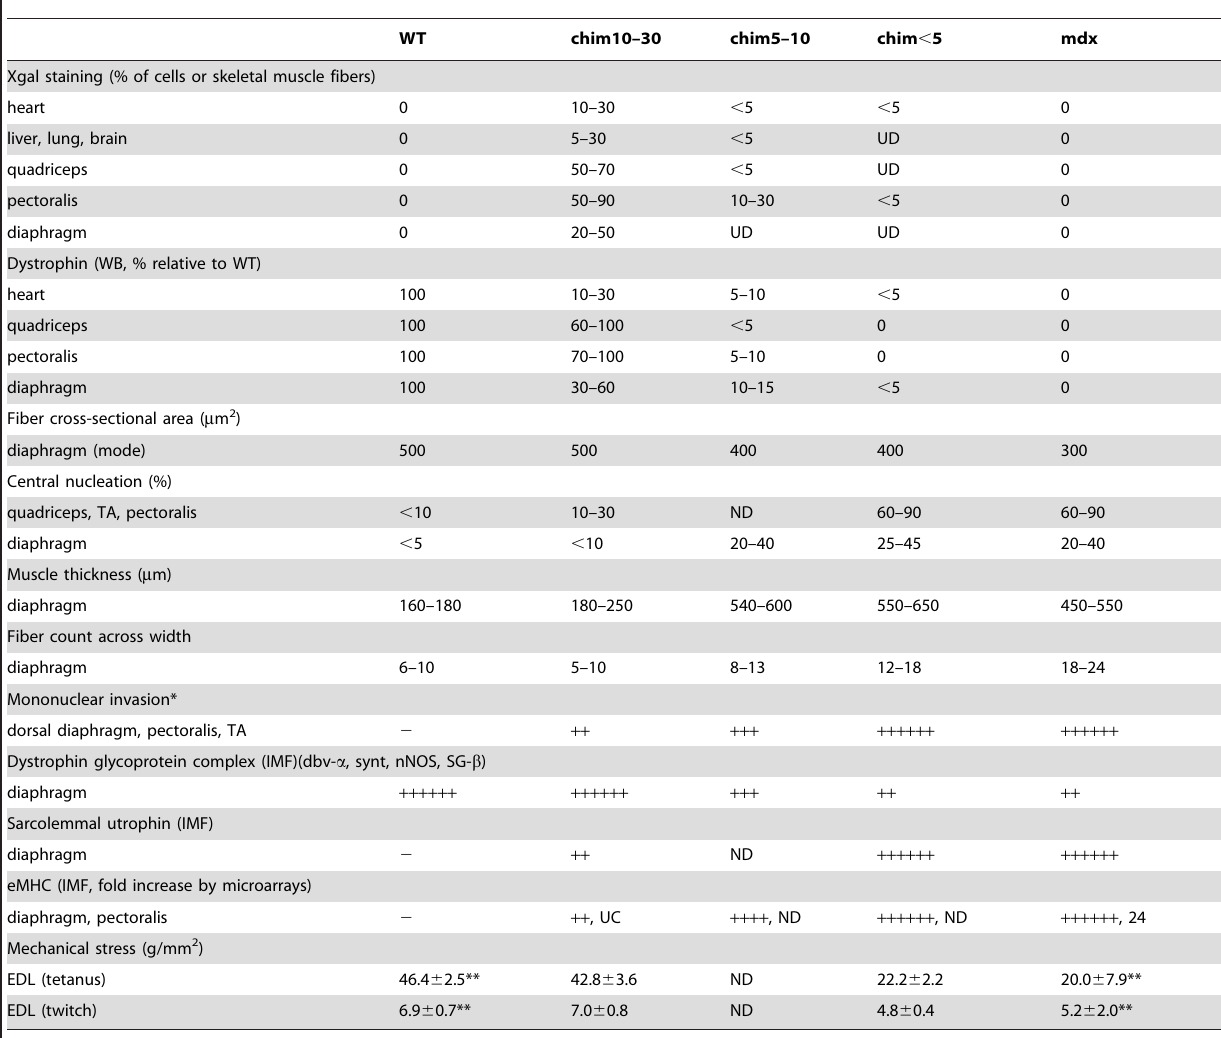
Table 1. The degree of chimerism correlates with the degree of